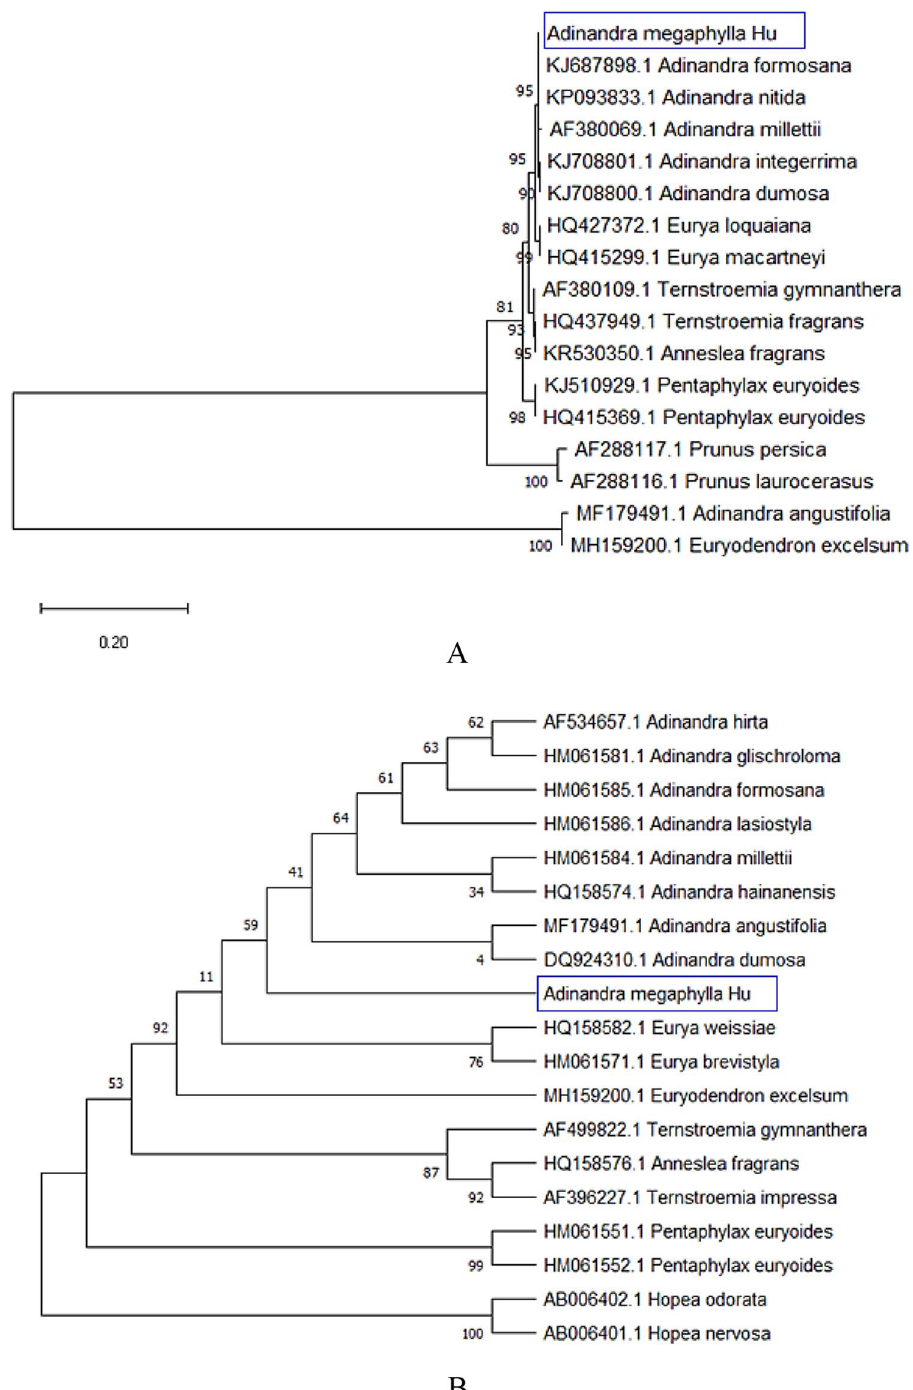
Figure 7. Phylogenetic relationship was inferred using the Maximum Likelihood method based on matK ( A ) and trnL ( B )